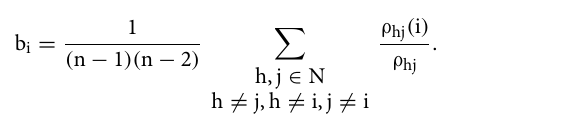
Figure 2. Graph theory application. Figure depicts various topological representations to help explain graph theory concepts. Circles represent a node, whereas the lines represent the edge or weight between each node. In ( A ), the arrow represents the shortest path from node B to node V. In ( B ), the red triangles represent closed triplets, whereas the dashed triangles represent possible